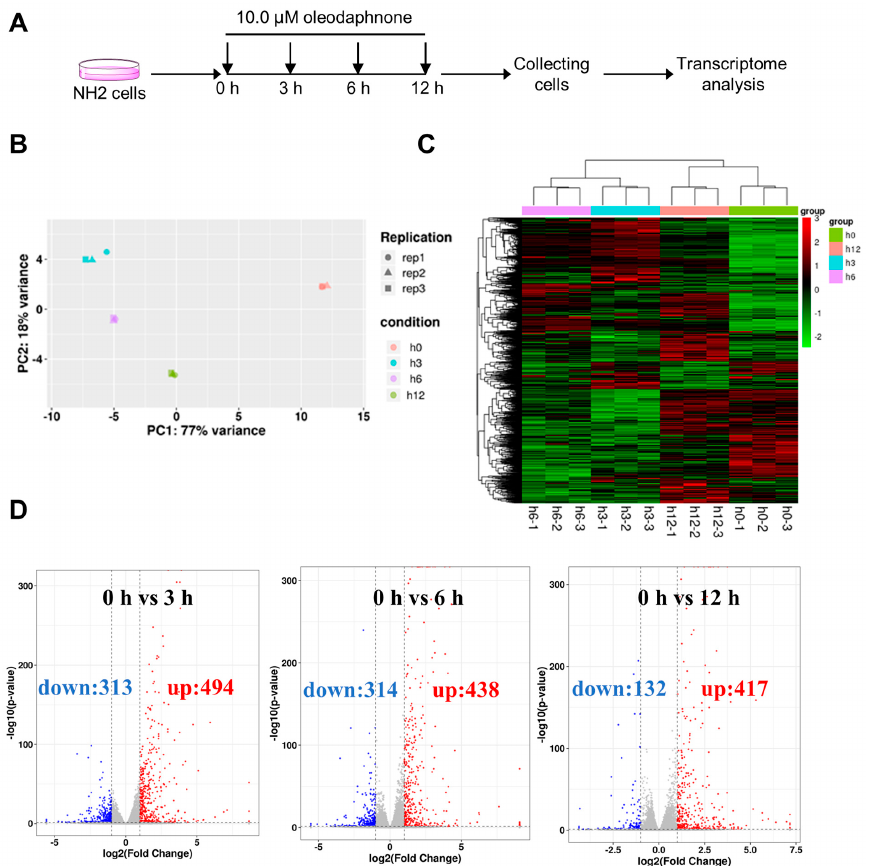
Figure 3. Time course evaluation of the gene transcription profiles of oleodaphnone-treated NH2 cells. ( A ) Diagram of the protocol used to generate samples for transcriptome-wide sequencing. NH2 cell cultures were treated with 10 µM oleodaphnone at the indicated time points and collected at the last time point. ( B ) PCA of 12 independent samples treated under the indicated conditions. The transcript levels of each independent sample were subjected to principal component analysis (PCA) regression of principal components. ( C ) Heatmap showing clustering of di ff erentially expressed genes in NH2 cells treated with oleodaphnone for di ff erent times. ( D ) The volcano plot of the mRNA-seq analysis of NH2 cells after oleodaphnone exposure. Red indicates upregulated differentially expressed genes (DEGs), and blue indicates downregulated DEGs.